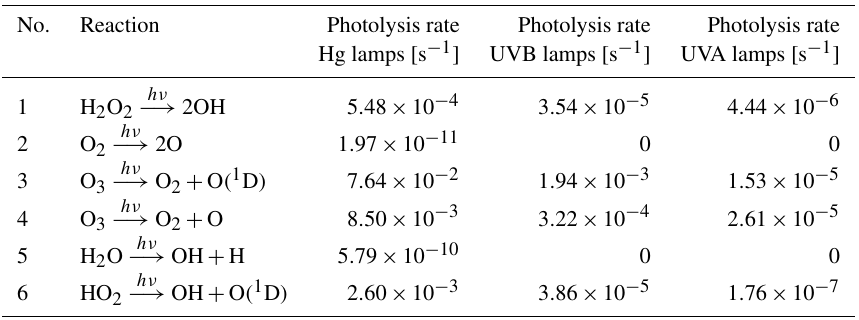
Table B1. Photolysis reactions in OH generation.